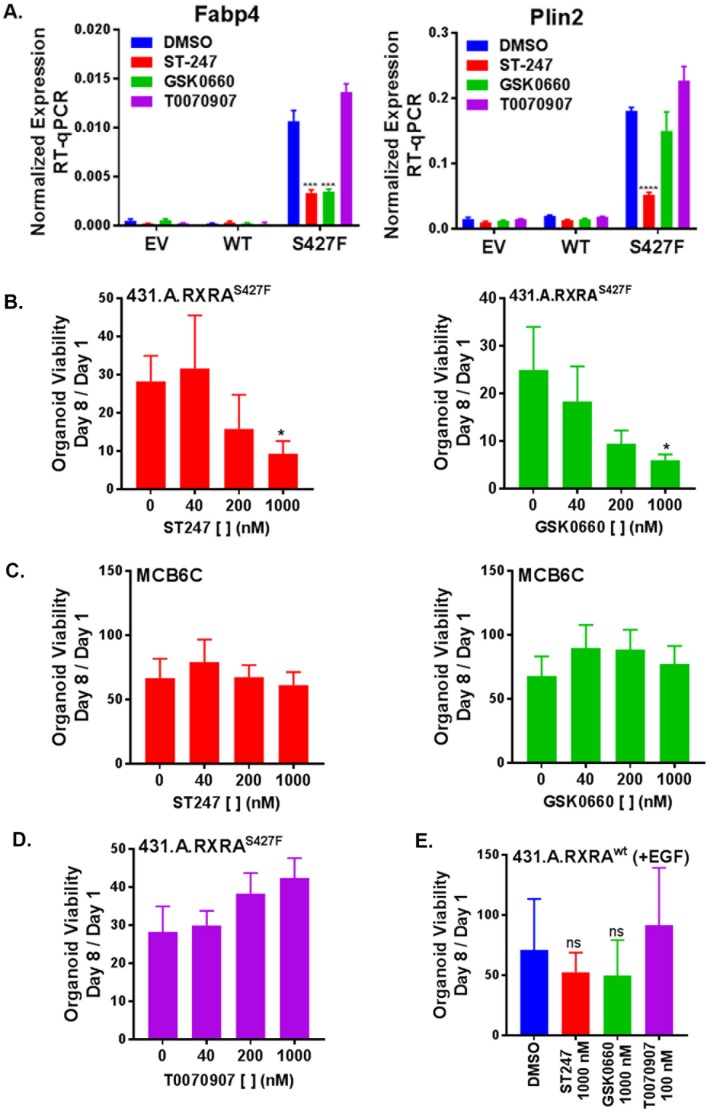
RXRA S427F generates PPARD-dependent urothelial growth.(A) Retrovirally transduced organoids from Figure 4 were plated for 7 days in standard media and then treated with the indicated PPARD antagonists (1000 nM ST-247, GSK0660) or PPARG antagonist (100 nM T0070907) for 2 days. Expression of PPAR targets was determined by RT-qPCR in triplicate ±SD and comparison is by Student’s t-test to the RXRAS427F DMSO condition. (See also Figure 5—figure supplement 1)) (B-E) CellTiter-Glo growth assay of indicated organoid lines treated with indicated drugs. Plotted is mean signal ±SEM from three independent experiments, each performed using triplicate organoid wells. MCB6C is an organoid line we derived from a carcinogen-induced bladder tumor and lacks RXRA mutation. Organoids were cultured in media without EGF except for panel E where inclusion of EGF is indicated. Comparison is to DMSO condition using paired t-test.